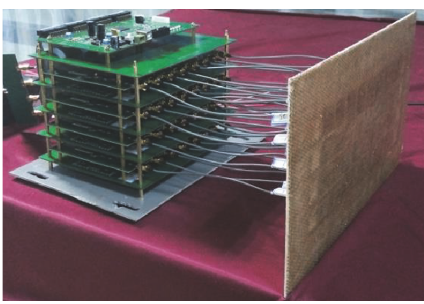
Figure 15: Measurements of active skin antenna